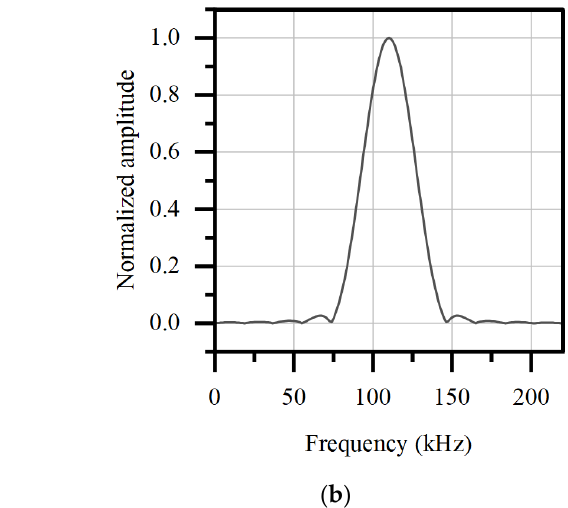
Figure 5. ( a ) Time domain diagram and ( b ) frequency domain diagram of excited signal.